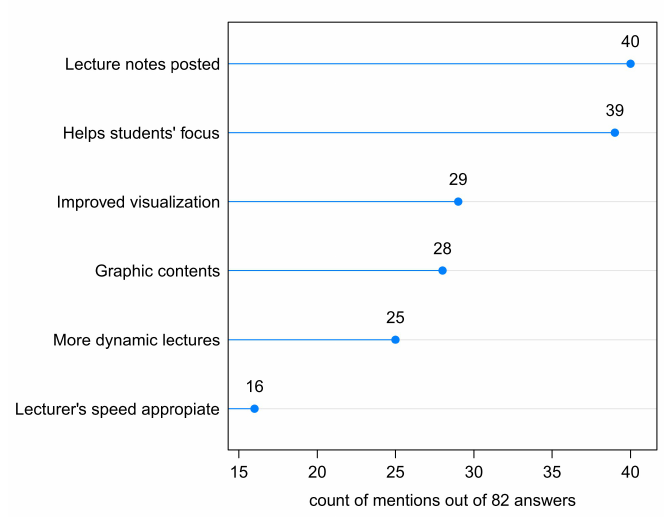
Figure 4. Queston 3 positve aspects of graphics tablet categorized in six main